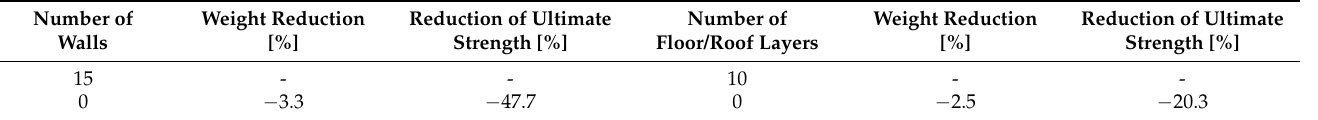
Table 8. Influence of selected printing parameters on the reduction of specimen weight and ulti- mate